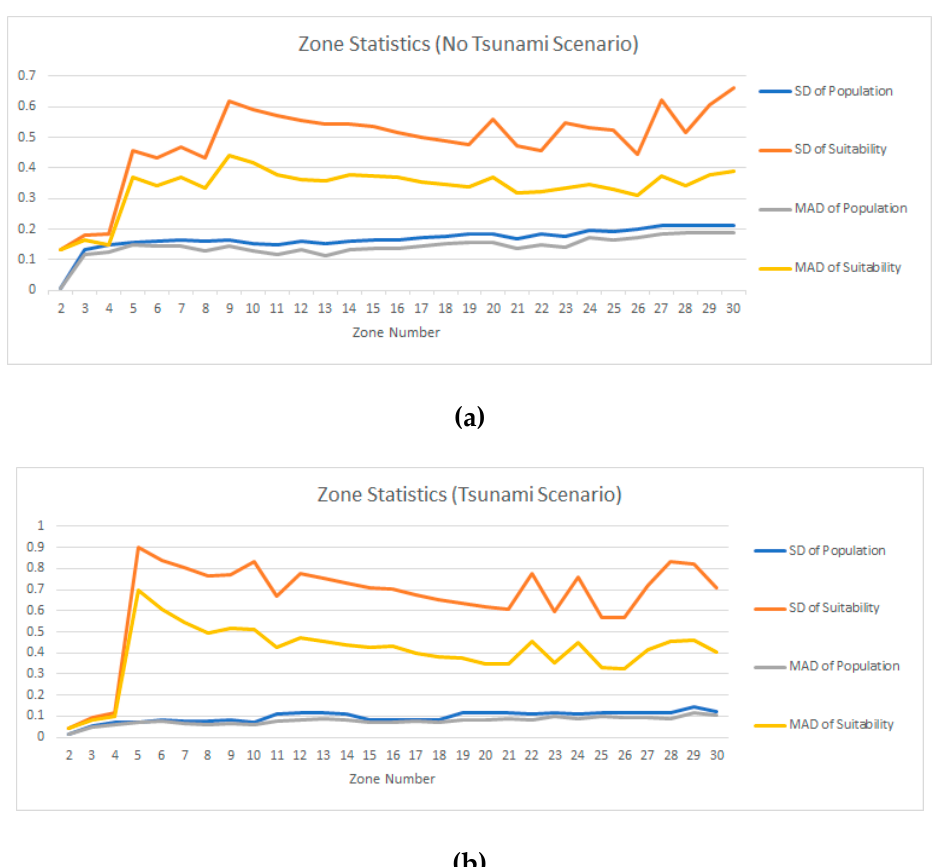
Figure 4. Zone statistics of standardized population and suitability of ( a ) no tsunami scenario and ( b ) tsunami scenario.